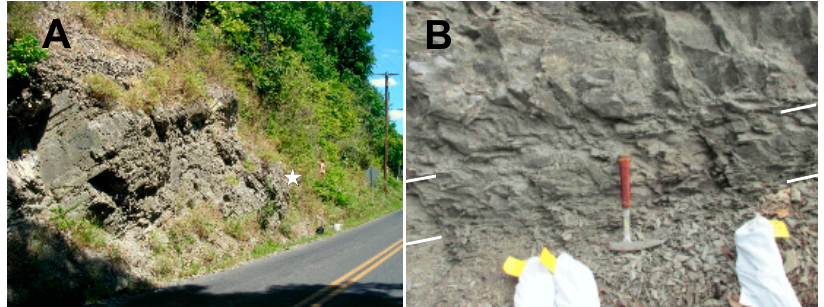
Figure 3. Microfossil outcrop, Lock Haven, PA. ( A ) Lower Tully Formation looking east along PA route 644. The lowermost knobby micritic calcilutites referred to in the text form the prominent ledge in the left foreground. Star shows the position of the microfossil horizon. Below these beds the exposure is heavily vegetated, but float indicates that the underlying rock is calcareous shale. The Tully-Windom contact lies past the utility pole at the right margin of the figure; ( B ) Close-up of the microfossil bed (between the white hachures) showing its irregular, knobby appearance. The top of the uppermost finely laminated, fissile calcareous shale typical of the beds extending down to the Tully-Windom contact can be seen below the microfossil bed. Hammer handle is about 25 cm long. The microfossil bed (Figure 3B) is black to dark gray in color on fresh surfaces, but weathers to light gray. No macrofossils co-occur with the microfossils, although irregular, pyritized burrows up to 10 cm in length and 2 mm in diameter are not uncommon. Shorter burrows up to 1 cm in diameter